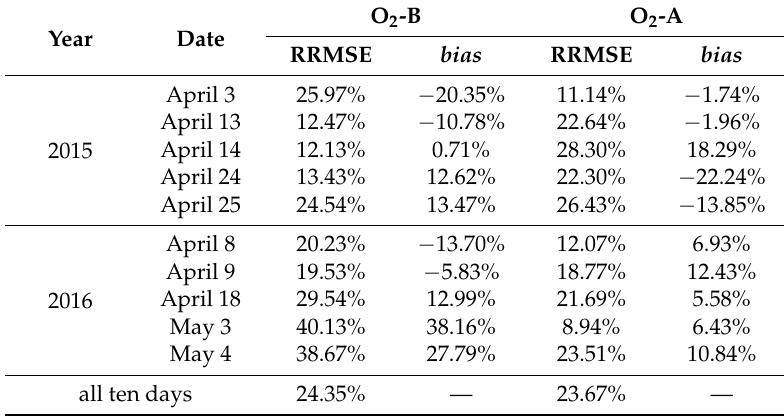
Table 4. The relative root mean square error (RRMSE) and bias of diurnal SIF simulations with fixed FQE at O 2 -B and O 2 -A bands on ten fieldwork